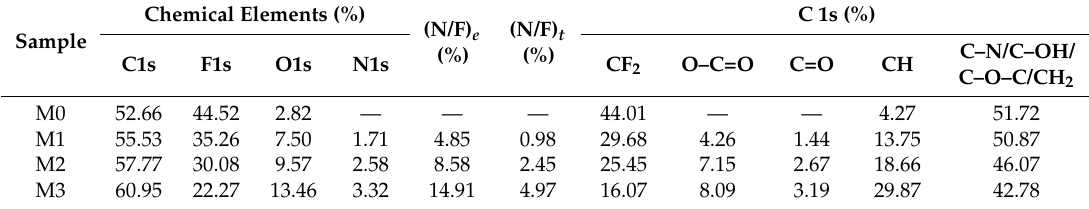
Table 2. Chemical compositions of membrane